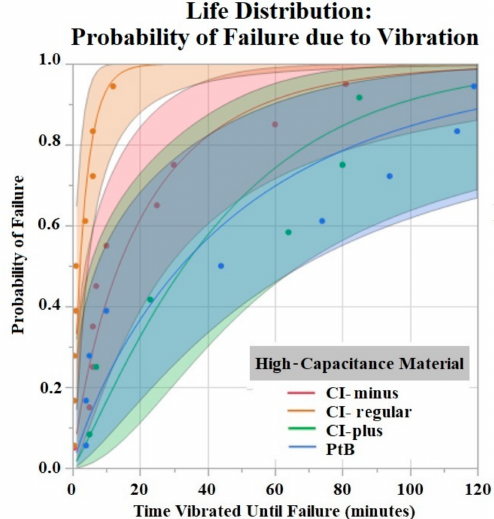
Figure 7. Weibull life distribution analysis of HCM groups. Binder concentrations for CI-Plus and CI-Minus are +60% and − 60% binder. The shaded area represents the confidence interval of each analysis.